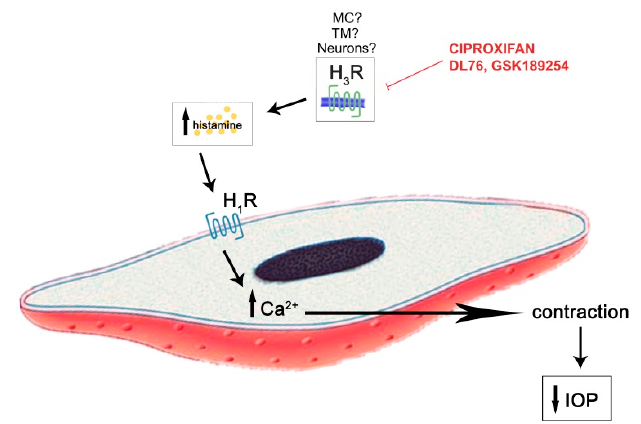
Figure 6. Hypothesized mechanism of action of H 3 receptor (H 3 R) antagonists in intraocular pressure (IOP) reduction: T-bar meaning antagonism, arrows meaning the hypothetic extracellular and intracellular mechanism of action of H 3 receptor antagonists, upward and downward arrows meaning increase and decrease respectively.